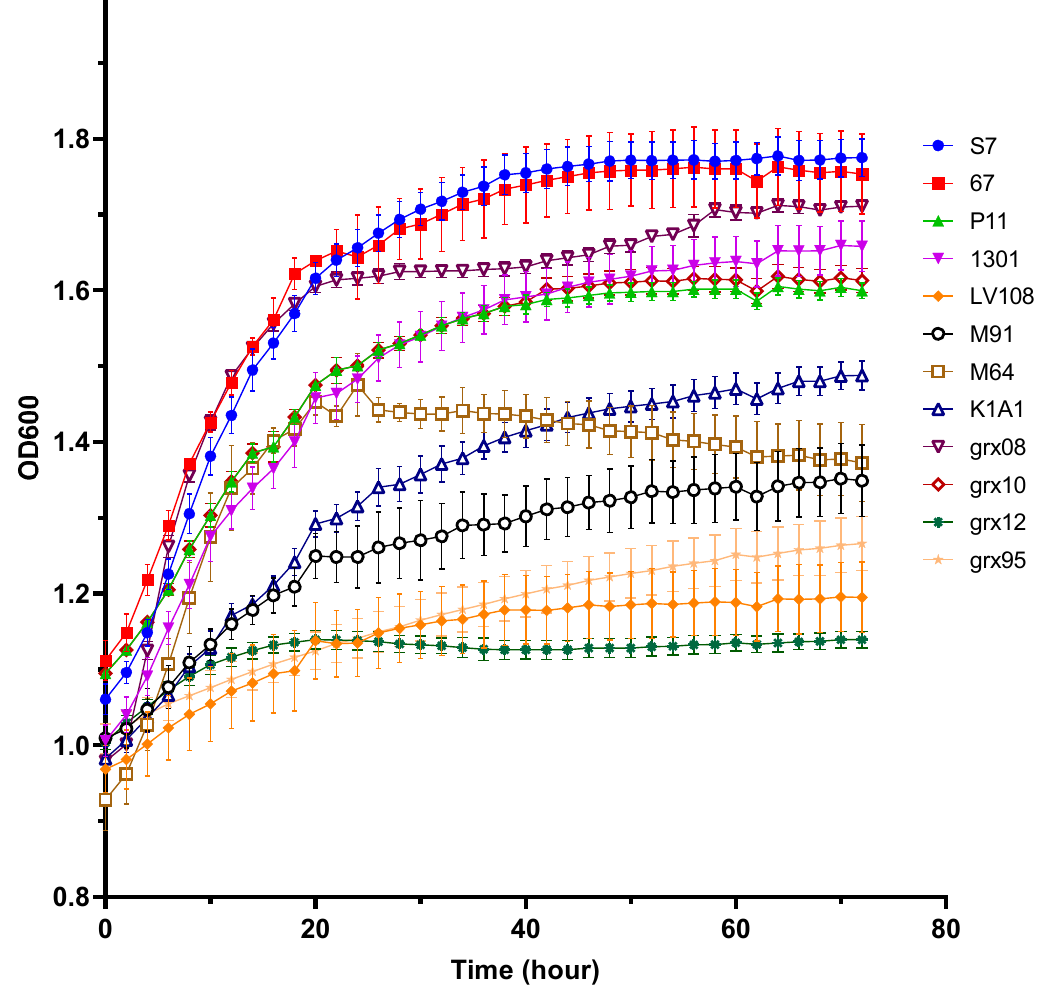
Figure 1. Growth curves of different lactic acid bacteria in SHLE.